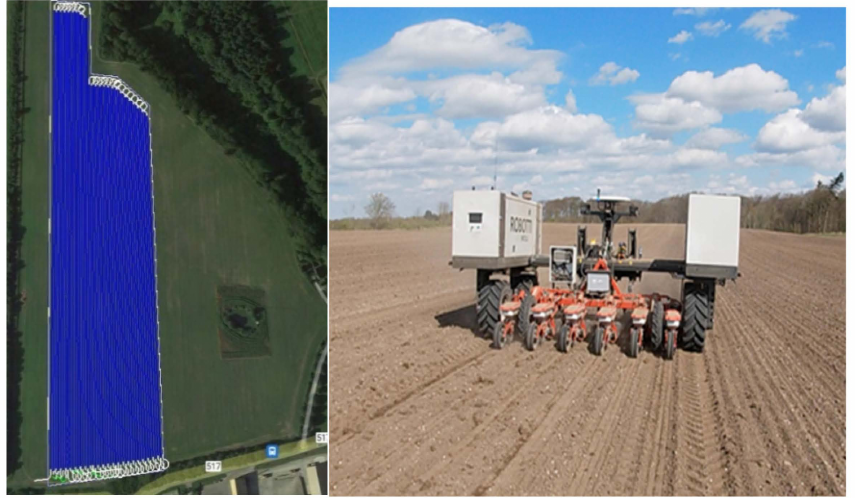
Figure 13. A sample field with a size equal to 7.5 (ha) was used for the seeding operation with the robot.